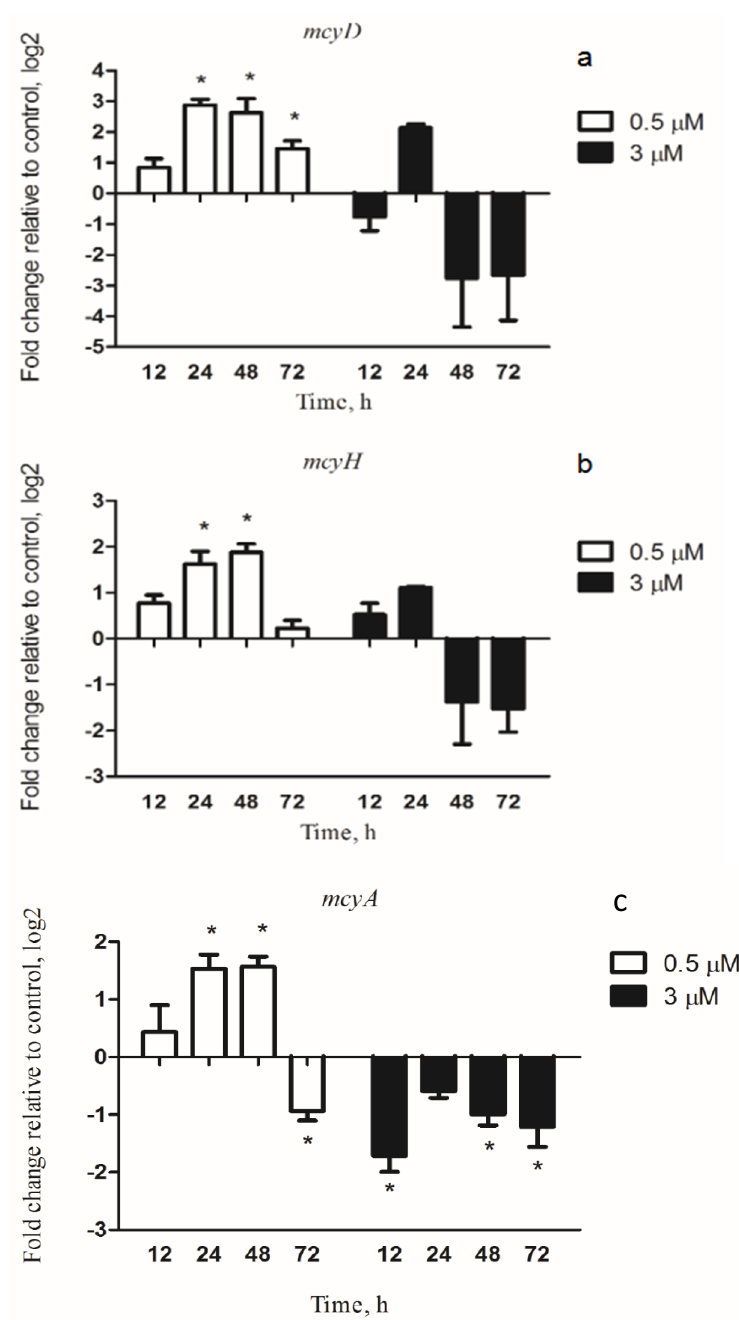
Figure 4. Relative expression levels of mcyD , mcyH and mcyA genes in M. aeruginosa PCC 7806 under copper stress. ( a ) the mcyD gene; ( b ) the mcyH gene. ( c ) the mcyA gene. The (0.5 µ M) M. aeruginosa cells were incubated with 0.5 µ M copper for 12, 24, 48, or 72 h. The (3 µ M) M. aeruginosa cells were incubated with 3 µ M copper for 12, 24, 48, or 72 h. Results are the mean ± SD from 3 separate determinations. * represents significance at p < 0.05 between copper-treated groups and the control